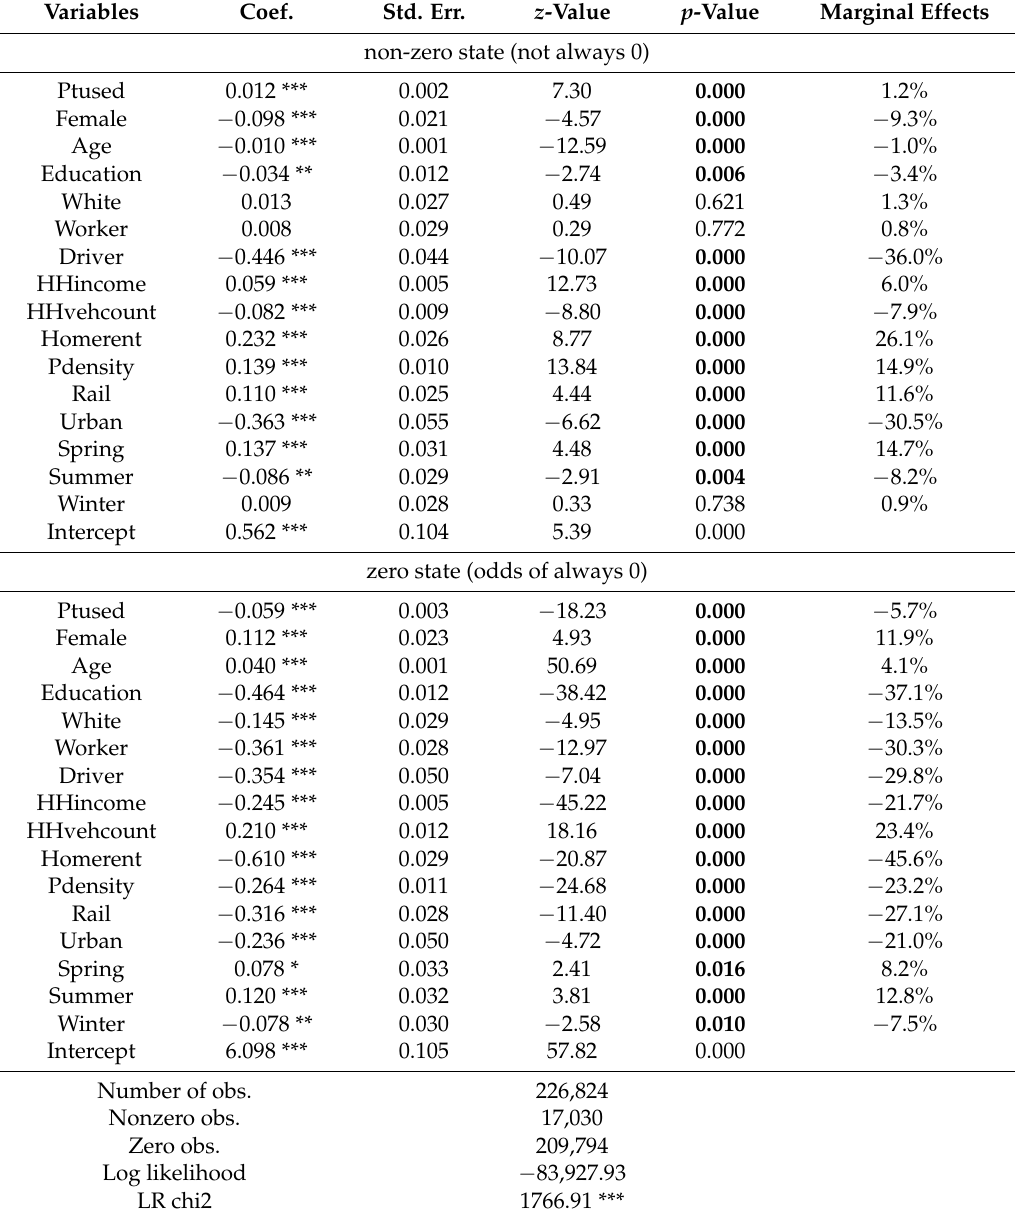
Table 2. Results for the relationship between ridesharing and public transit use (dependent variable: